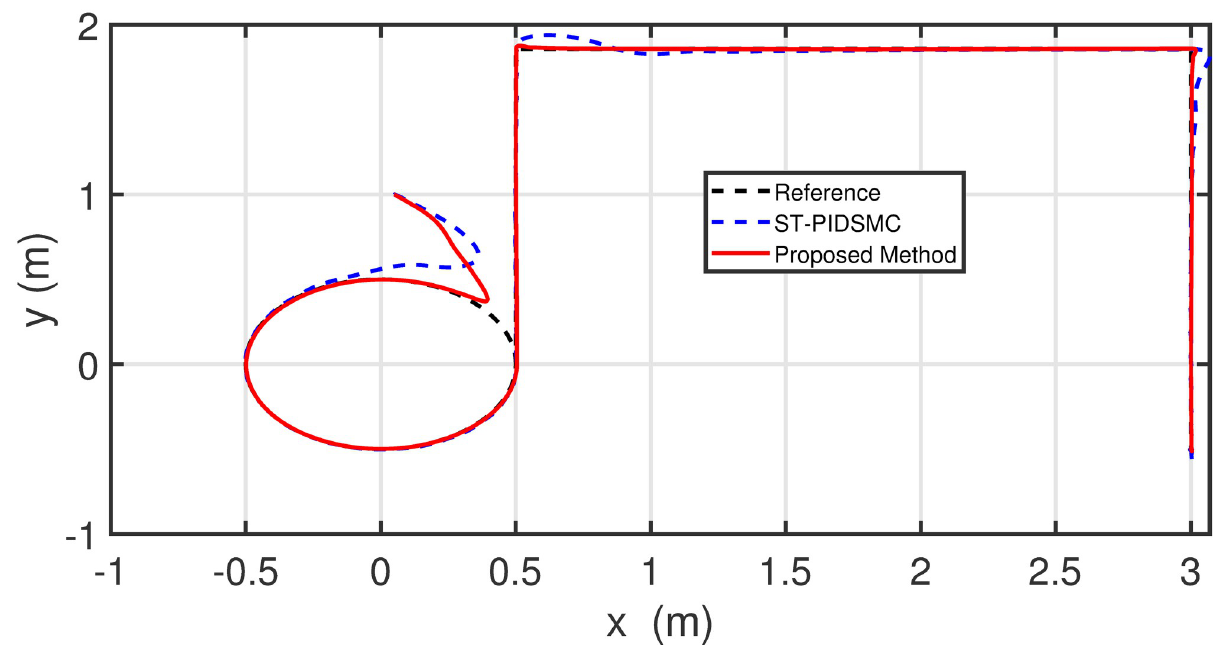
Fig 10. Results of the path following in 2D space under the proposed controller. https://doi.org/10.1371/journal.pone.0283195.g010 PLOS ONE | https://doi.org/10.1371/journal.pone.0283195 April 24,